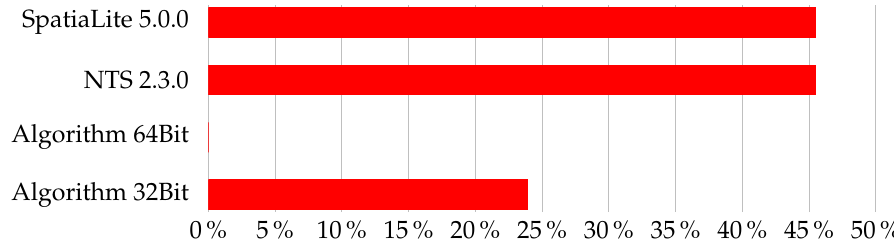
Figure 14. Failed scalings (percent of total 1980